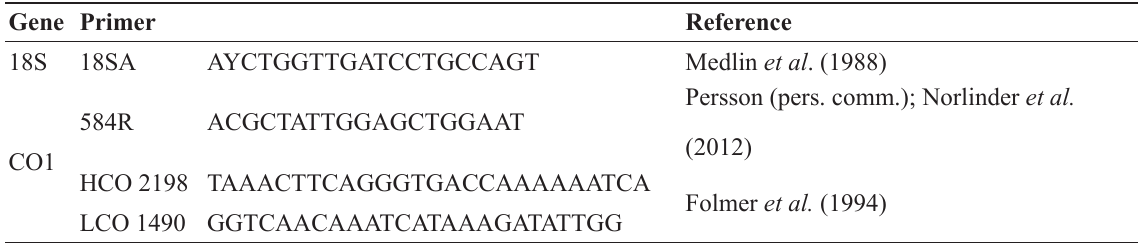
Table 2. List of PCR and sequencing